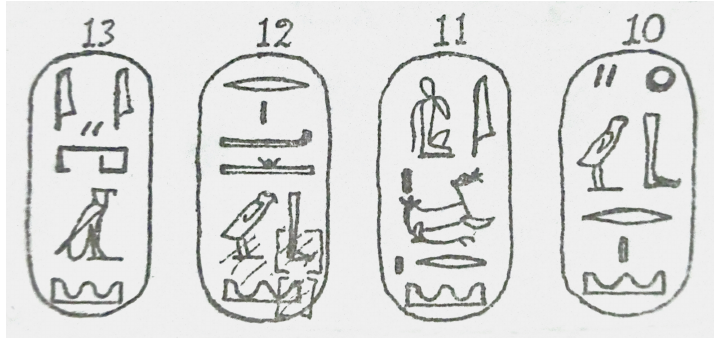
Figure 2 Toponyms of Ramses III from Madinat Habu: 10. Hebron , 11. Reḥob , 12. Athar , 13. Yahw (Kitchen 1979, 260, Line